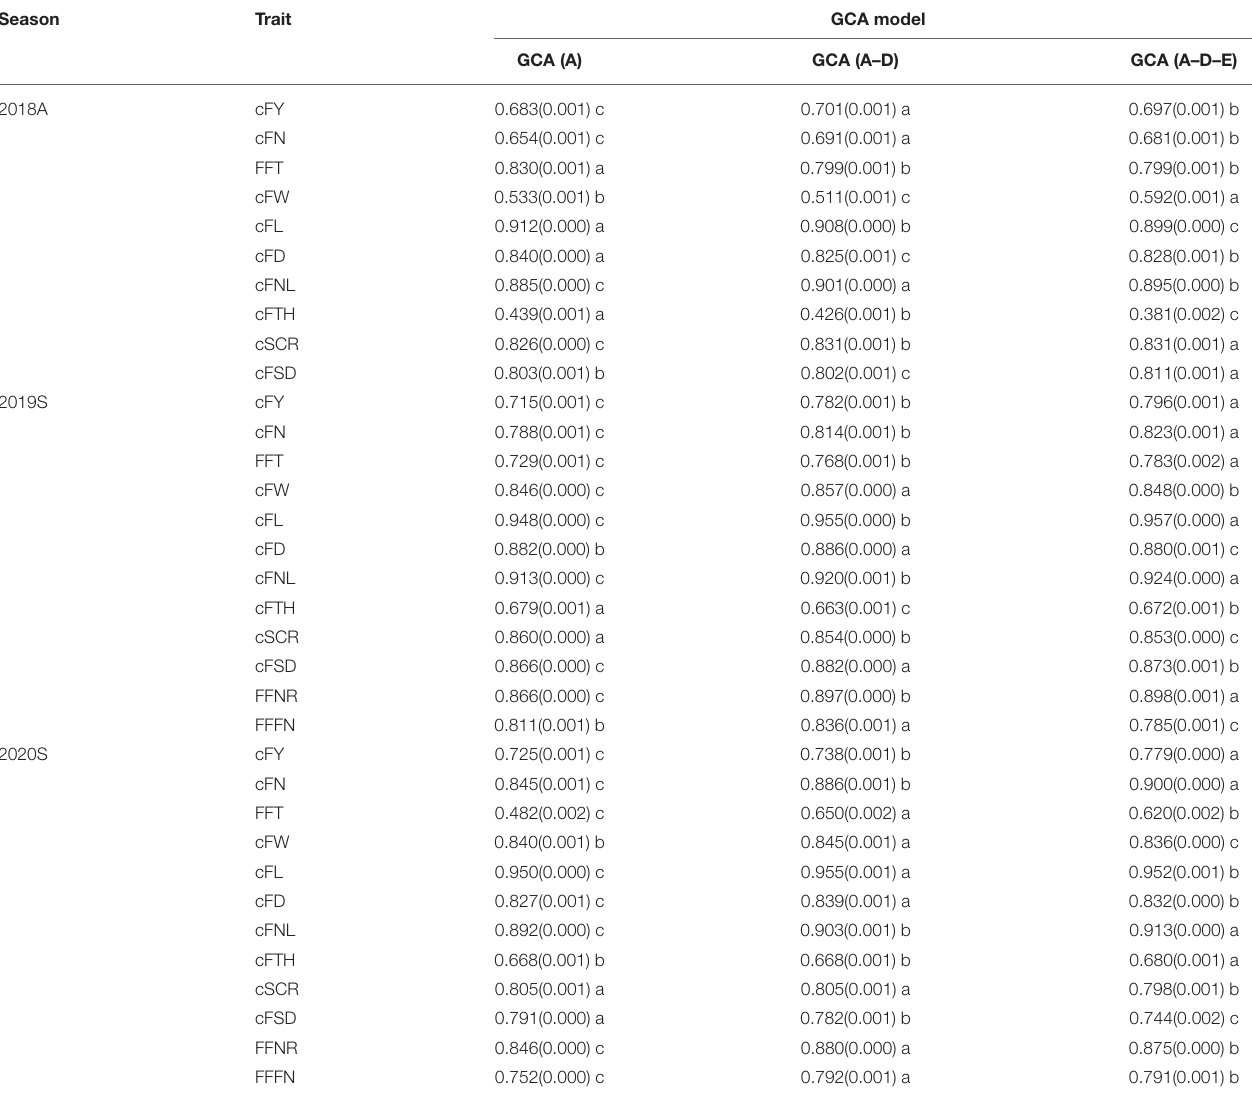
TABLE 1 | Predictive ability of GCA models under the five-fold cross-validation